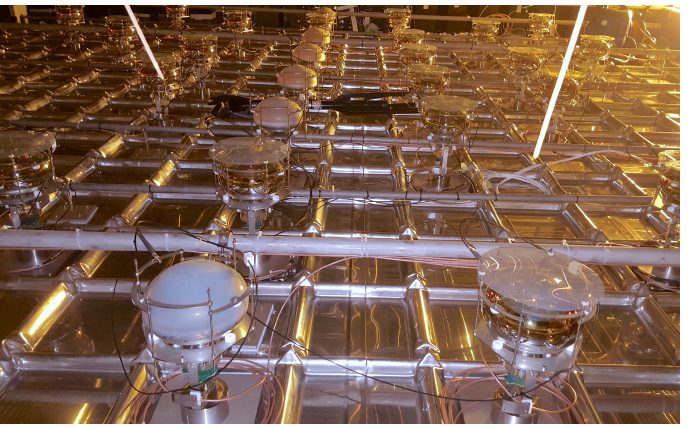
Figure 15. ProtoDUNE-DP PDS formed of 36 PMTs installed at the bottom of the cryostat at CERN. Spanish groups have developed the simulation of the ProtoDUNE-DP PDS and scintil- lation light processes and are the leaders of the analysis of the scintillation light data